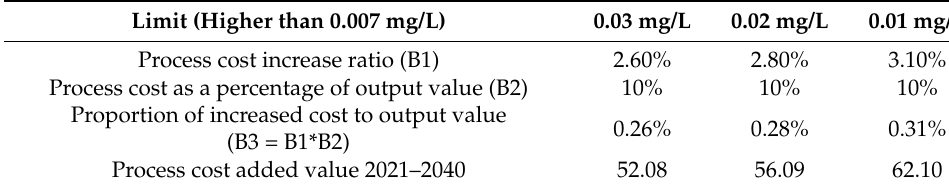
Table 8. Process cost expenses due to the limit change.